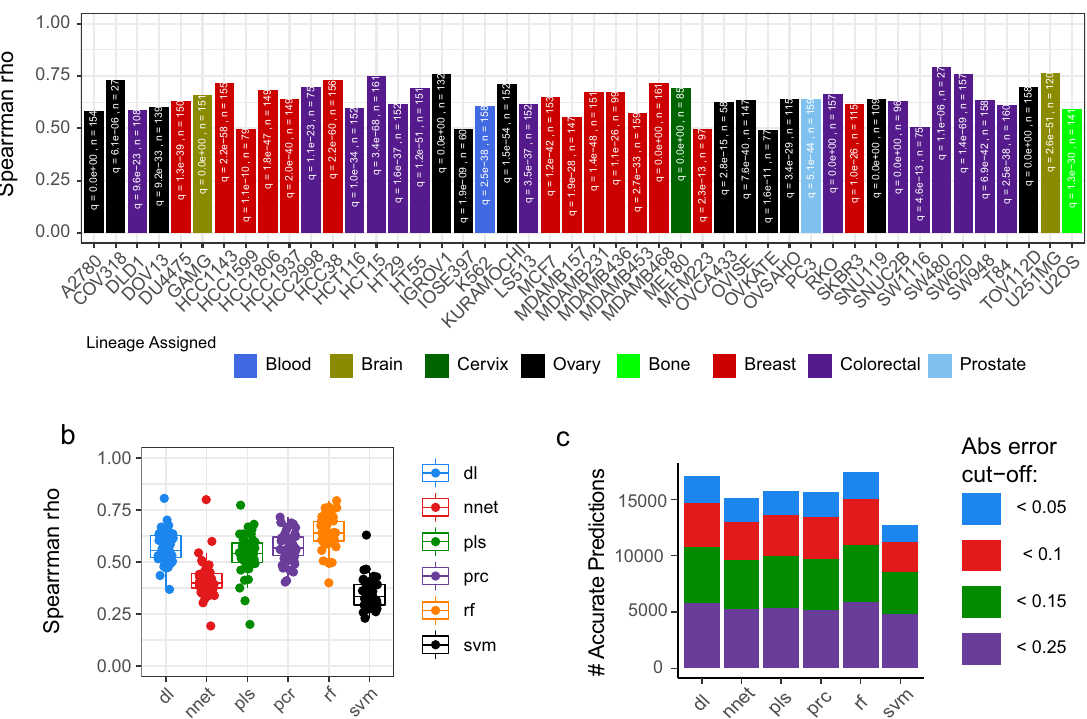
Correlation predicted vs measured responses by RF models, input: proteomics data (Jarnuczak et al )